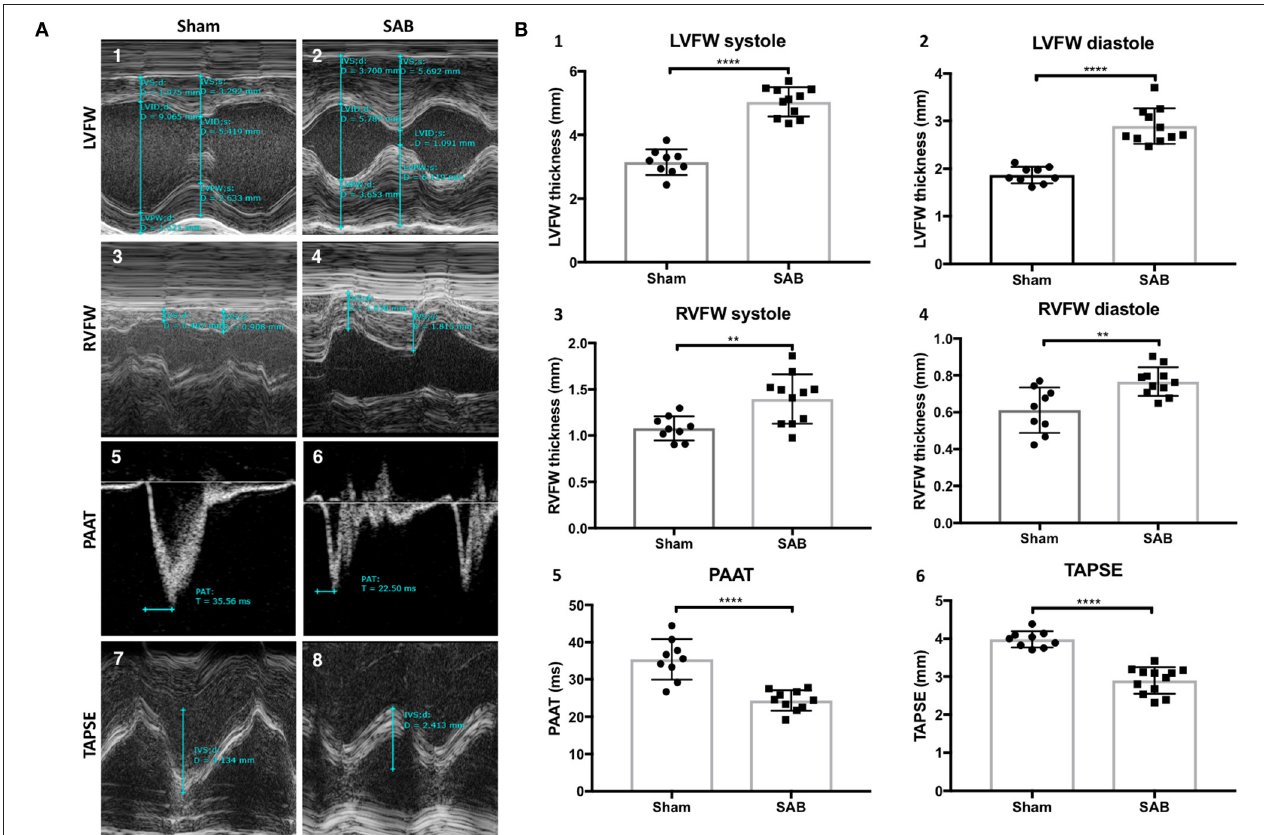
FIGURE 1 | Echocardiographic measurements of sham vs. supra-coronary aortic banding (SAB) rats at 4 weeks post banding. (A) Representative echocardiographic images showing development of group 2 PH in SAB rats. (1–2) Left ventricular free wall thickness (LVFW), (3–4) right ventricular free wall thickness (RVFW), and (5–6) pulmonary artery acceleration time (PAAT), and (7–8) tricuspid annular plane systolic excursion (TAPSE) of sham vs. supra-coronary aortic banding (SAB) rats. (B) Summary statistics showing significant increase of biventricular thickness and decrease of PAAT and TAPSE in SAB vs. sham. (1) LVFW thickness, (2) diastolic LVFW thickness, (3) RVFW thickness, (4) diastolic RVFW thickness, (5) PAAT, (6) TAPSE of sham vs. supra-coronary aortic banding rats.